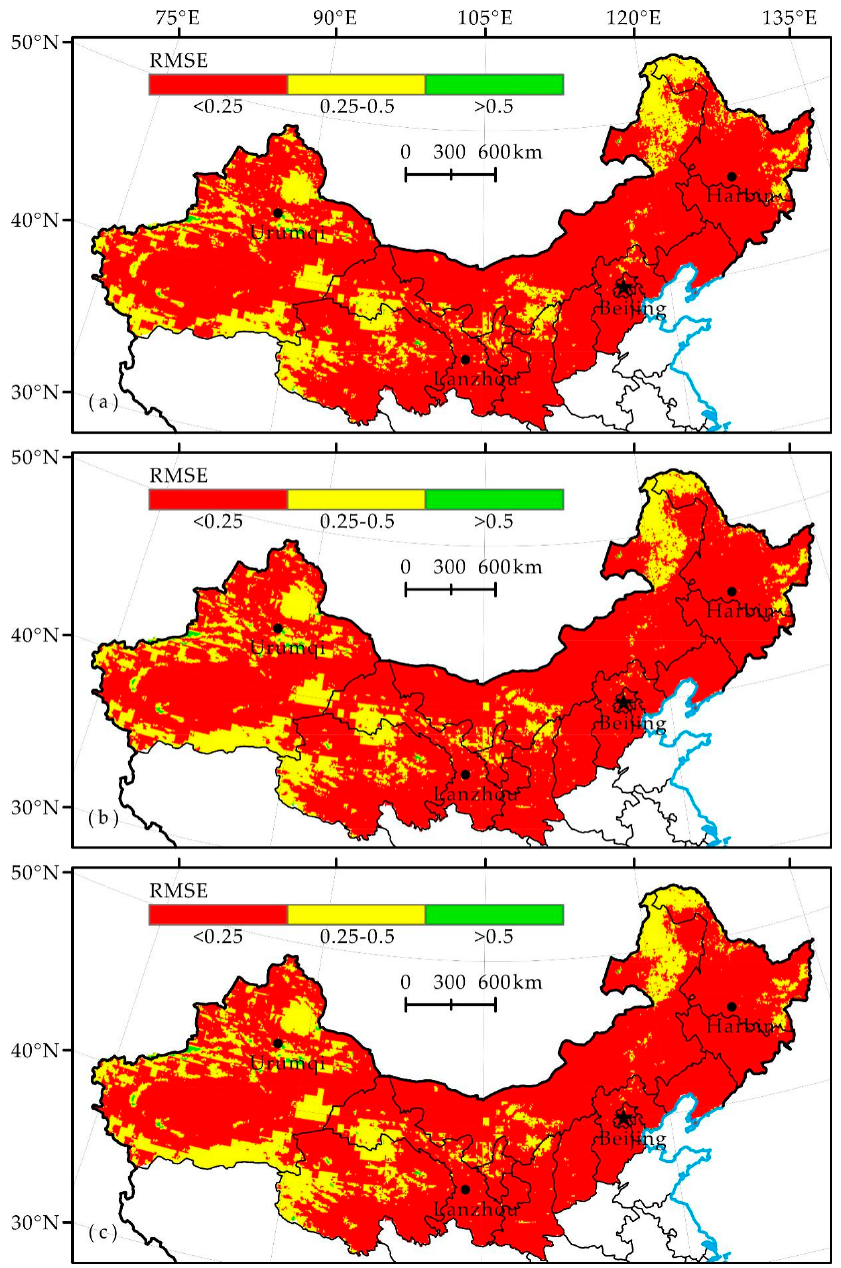
Figure A1. Root Mean Square Error (RMSE) Distribution of NDVIpot and Actual NDVI of Northern China Simulated Based on the Most Suitable Linear Regression Model (( a ) 1982–1990; ( b ) 1982–2000; ( c ) 1982–2012)). Table A1. RMSE (Root Mean Square Error) Distribution of NDVIpot and Actual NDVI of Northern China.